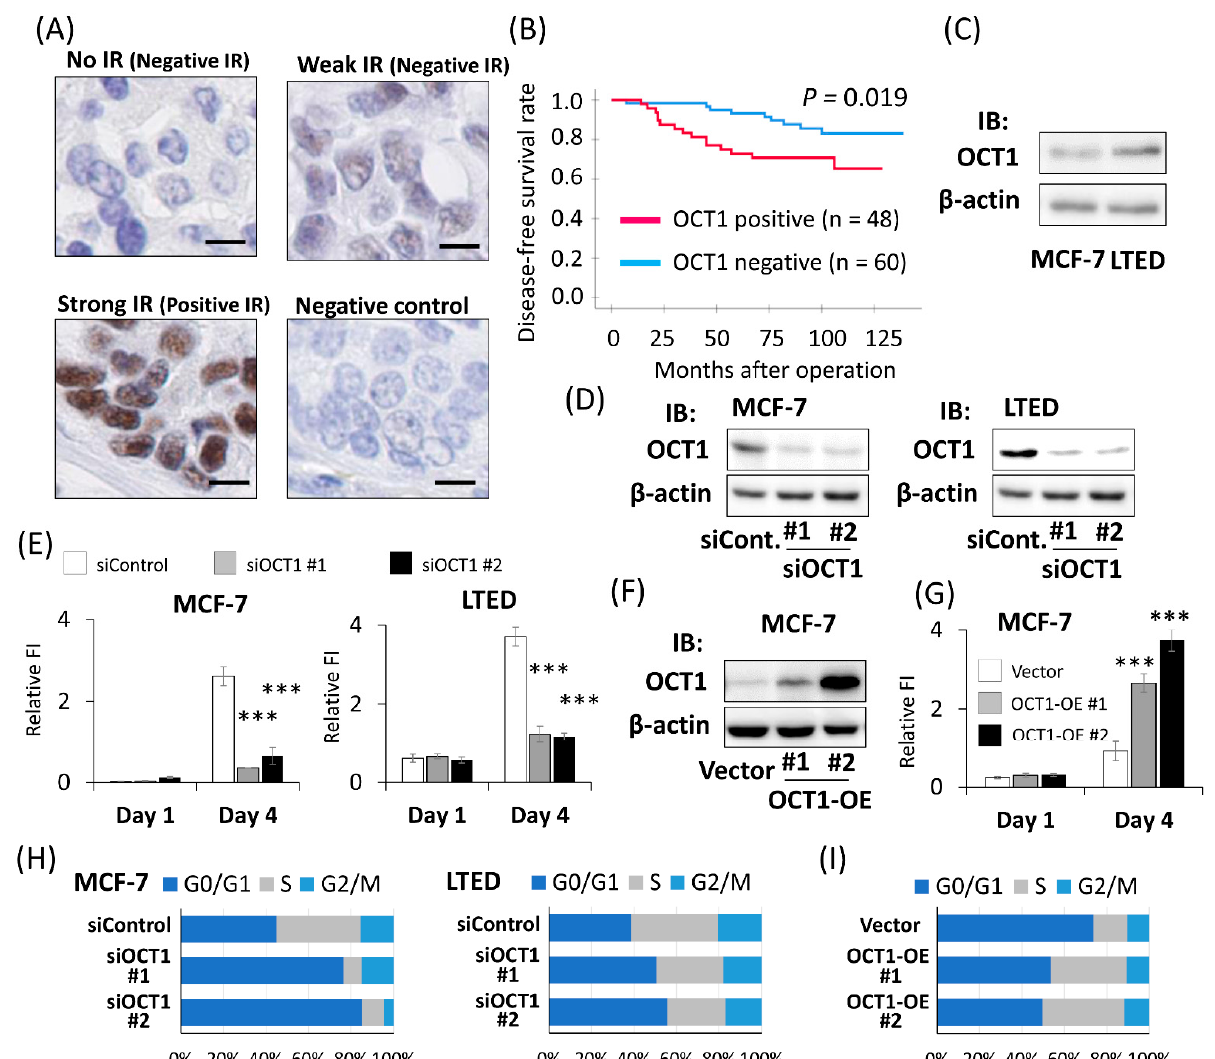
Figure 1. OCT1 was a poor prognostic factor in ER-positive breast cancer patients. ( A ) Representative micrographs of breast cancer tissues stained with OCT1 antibody. Strong immunoreactivity (IR) was defined as positive IR, whereas weak IR or no IR was defined as negative IR. A breast cancer tissue was applied to non-specific rabbit IgG antibody as a negative control. The scale bars represent 10 µ m. ( B ) Disease-free survival of breast cancer patients with positive or negative OCT1 IR is shown by the Kaplan-Meier method. p -value was determined by the log-rank test. The red line represents cases with positive OCT1 IR ( n = 48), and the blue line represents negative OCT1 IR ( n = 60). ( C ) Western blot analysis for OCT1 expression in MCF-7 cells and LTED cells. β -actin protein was blotted as a loading control. IB, immunoblot. ( D ) Western blot analysis for OCT1 expression in MCF-7 cells and LTED cells treated with two kinds of siRNAs for OCT1 (siOCT1 #1 or #2) or siControl (siCont.). β -actin protein was blotted as a loading control. ( E ) DNA content of MCF-7 and LTED cells on indicated days after transfection of indicated siRNAs analyzed by Hoechst 33342 staining. Relative fluorescence intensity (FI) was shown as mean and SEM ( n = 4). *** p < 0.001 compared to cells treated with siControl. ( F ) Western blot analysis for OCT1 expression in two clones of MCF-7 cells stably expressing OCT1 (OCT1-OE #1 and #2) and an MCF-7 clone transfected with empty vector (Vector). β -actin protein was blotted as a loading control. ( G ) DNA content of the OCT1-OE clones (#1 and #2) and the vector clone (Vector) on indicated days after seeding was analyzed by Hoechst 33342 staining. Relative fluorescence intensity (FI) was shown as mean and SEM ( n = 4). *** p < 0.001 compared to the vector clone. ( H ) Proportions of cell populations in G0/G1, S, and G2/M phases of the cell cycle in MCF-7 and LTED cells transfected with indicated siRNAs. The results of flow cytometric analysis shown in Figure S4B were quantified. ( I ) Proportions of cell populations in G0/G1, S, and G2/M phases of the cell cycle in the OCT1-OE clones (#1 and #2) and the vector clone (Vector). The results of flow cytometric analysis shown in Figure S4C were quantified.